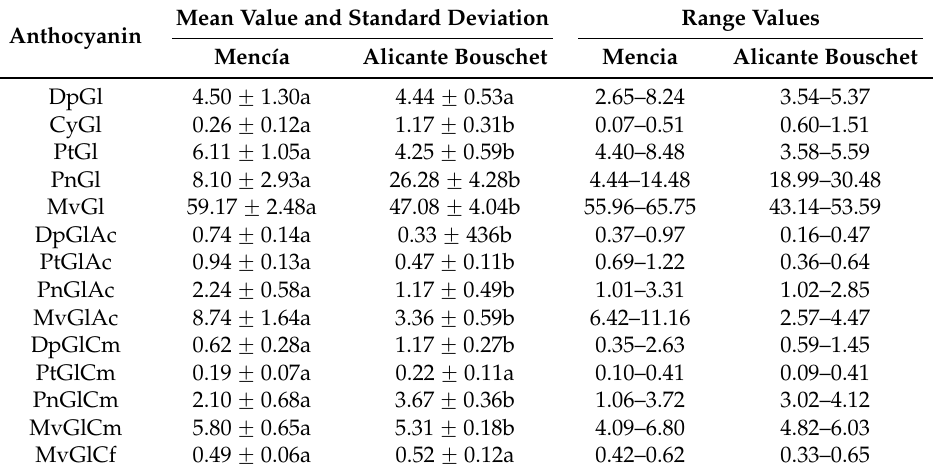
Table 7. Mean values, standard deviations and range values for the relative content of 14 anthocyanins in young red Mencia and Alicante Bouschet wines. Mean values in the same row followed by a different letter are significantly different ( p <